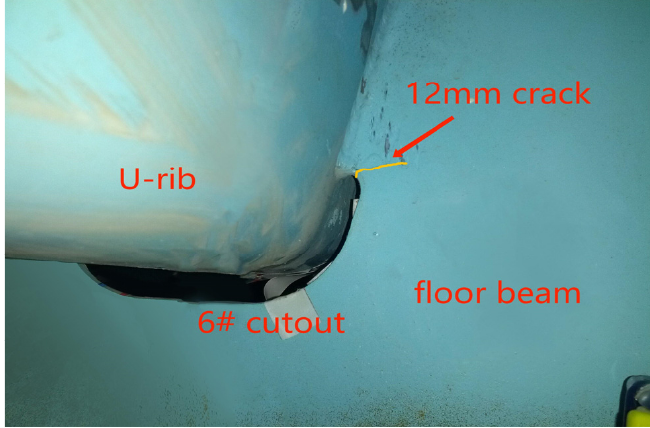
Figure 2. Geometry of U-rib and cutout details in fatigue model (in mm).